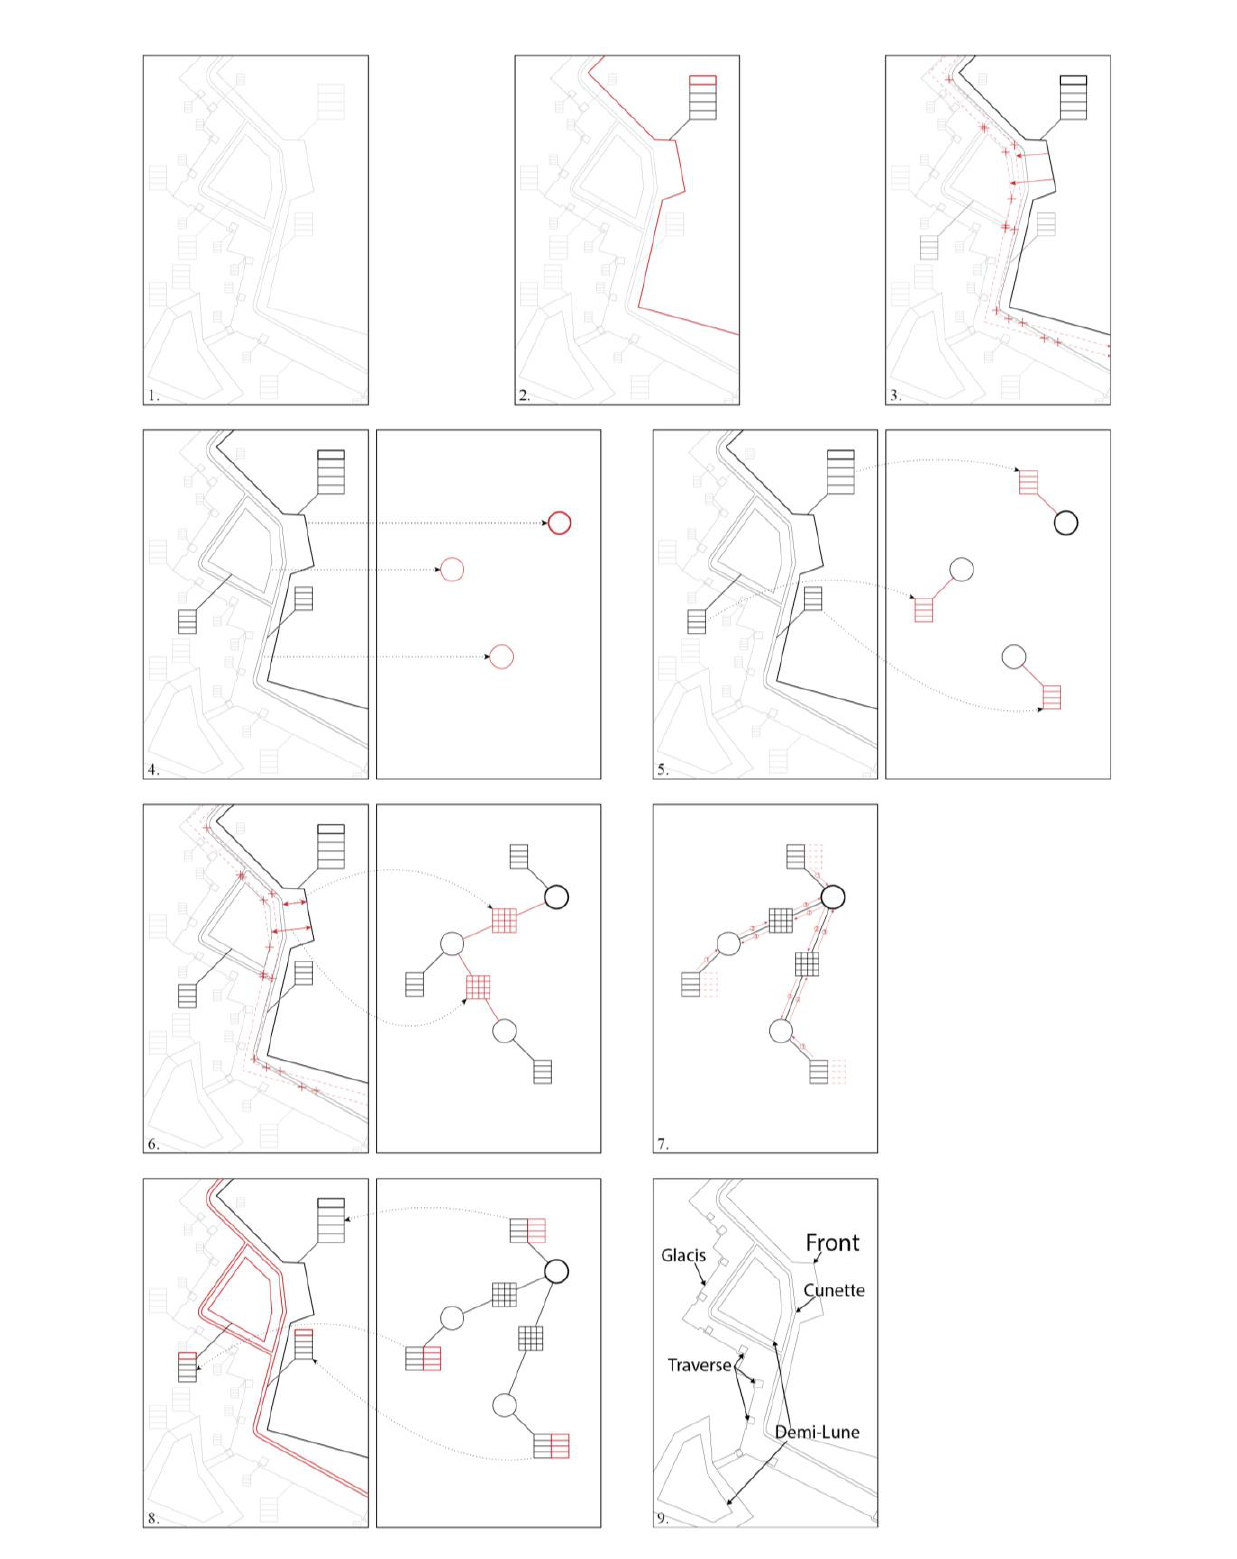
Figure 7. Consistency Evaluation Heuristic, identification of military architectural elements according to the morphology of the architectural system using a factor-graph abstraction and inference based on loopy belief propagation 1: Segmented geometry. 2-3: Propagation from the bastioned front (core fortification system element). 4: abstraction of the segmented geometry in nodes (variable vertices). 5: Adding unary factor vertices from precomputed geometric evaluation. 6: Adding binary factor vertices from the theoretical relations 7-8: Message passing via belief propagation 9: Identification, Semantisation